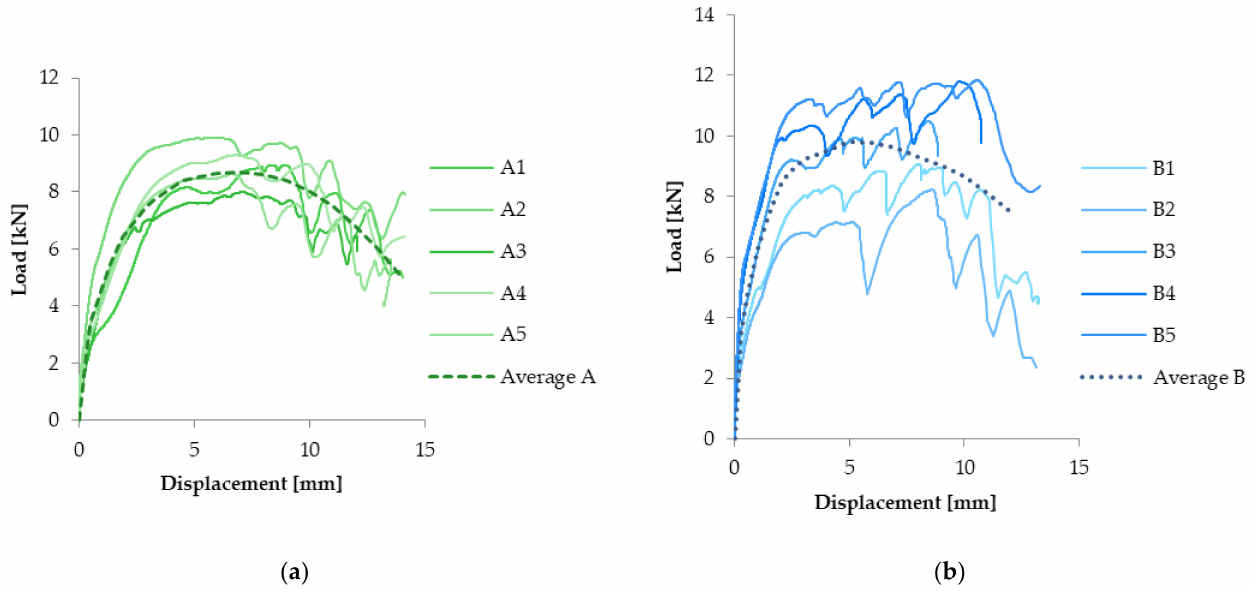
Figure 14. Load-displacement curves: ( a ) joint A; ( b ) joint